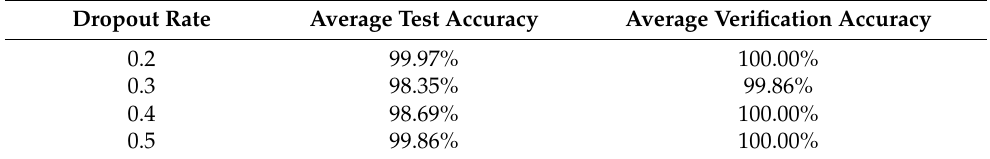
Table 6. Results of five round crossover experiments with different dropout rates.